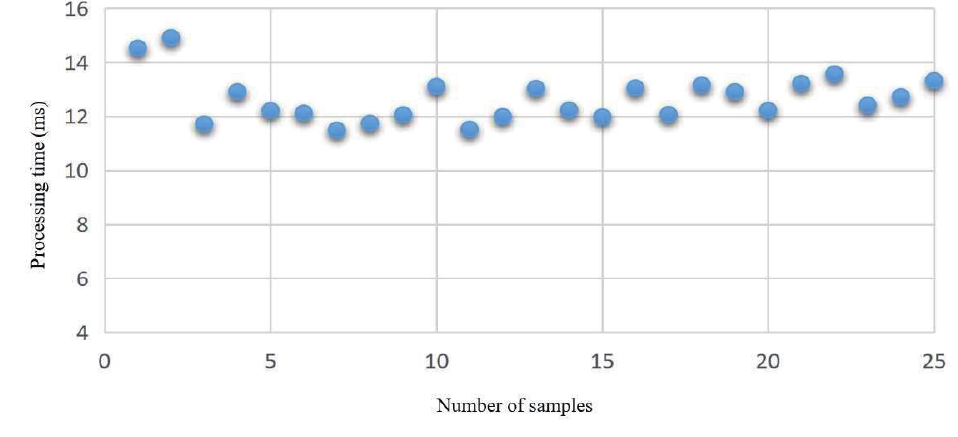
Figure 17. The processing time for 20